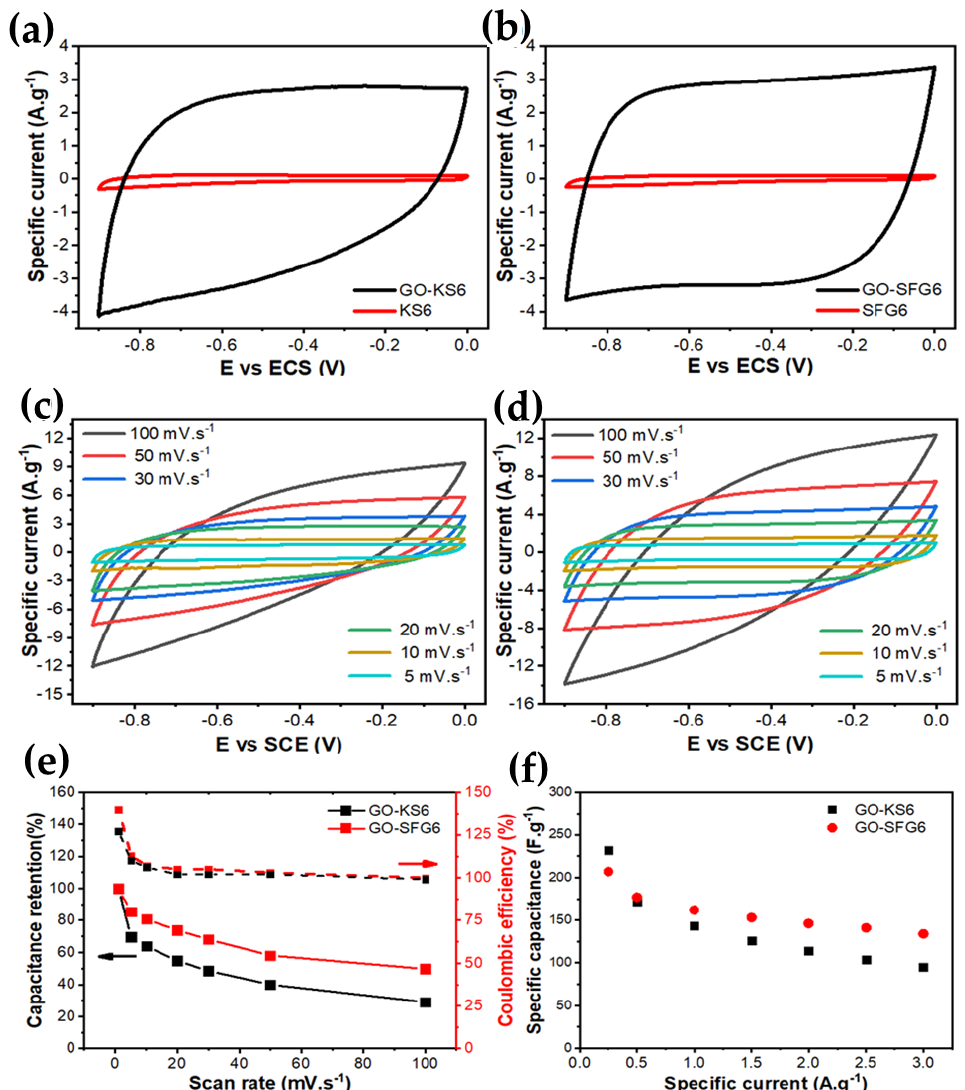
Figure 4. ( a ) The CV comparison between KS6 graphite and GO-KS6, ( b ) the CV comparison be- tween SFG6 graphite and GO-SFG6, ( c ) the CV curves of GO-KS6 at different scan rates, ( d ) the CV curves of GO-SFG6 at different scan rates, ( e ) the capacitance retention at different scan rates, and ( f ) the specific capacitance at different specific currents in the galvanostatic charge –